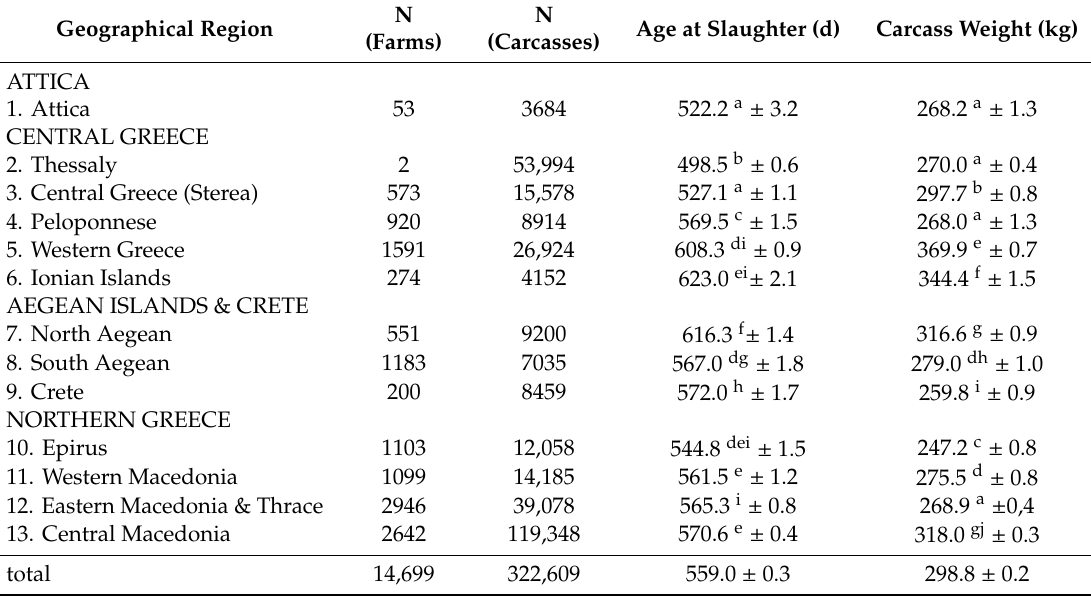
Table 3. Number of cattle farms and beef carcasses (N), means ± std. error for the age at slaughter (days) and carcass weight (kg) distributed in the 13 geographical